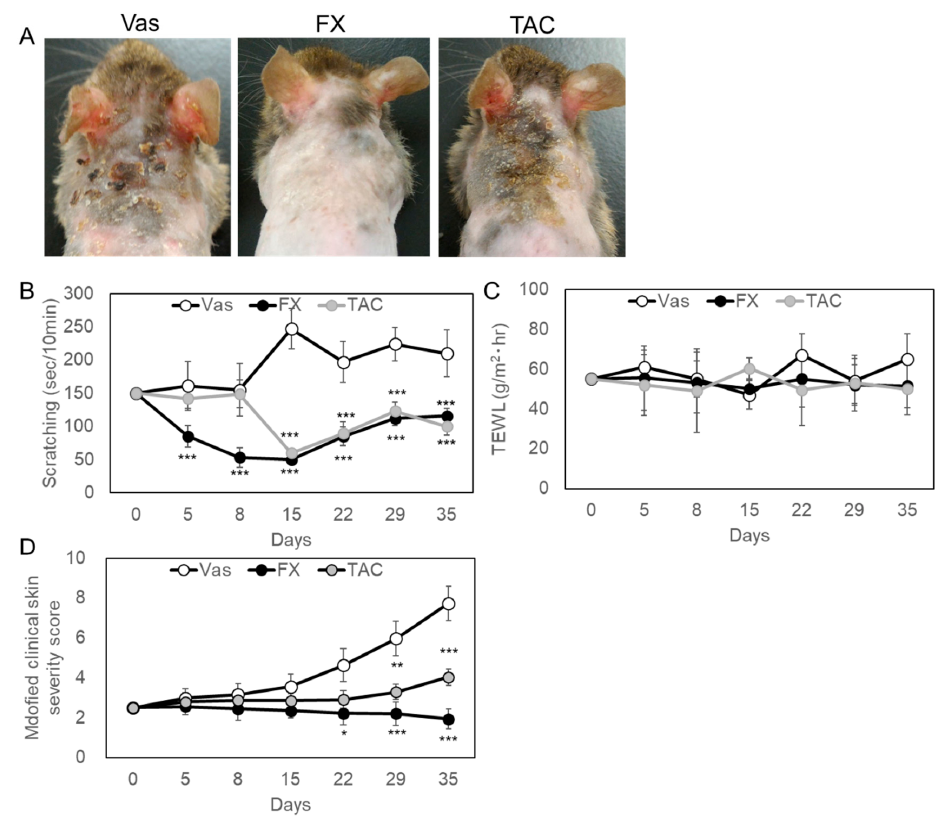
Figure 1. Feature of typical experimental findings in fucoxanthin (FX) or tacrolimus (TAC) treated Nc/Nga mice. Vaseline (Vas), Vas containing FX or TAC were applied to shaved back skin daily for five weeks. Shaving was performed every two weeks. ( A ) Mice skin symptoms after five weeks of